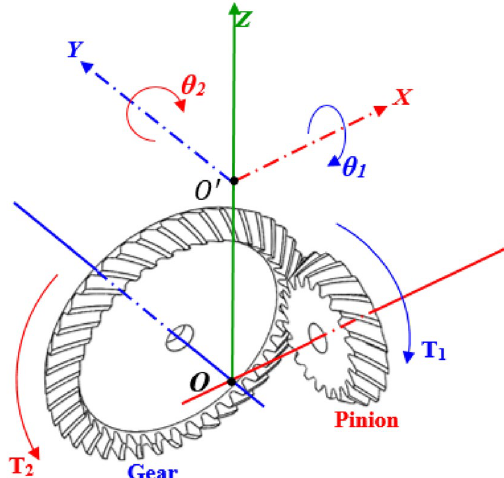
Fig. 2 The dynamic model of a spiral bevel gear system with rota- tional degrees of